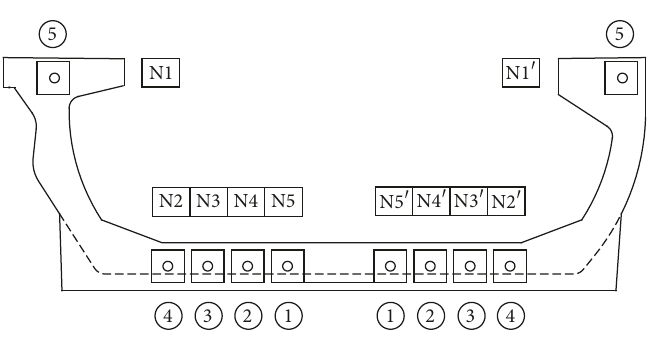
Figure 8: Prestressing sequence of U-shaped